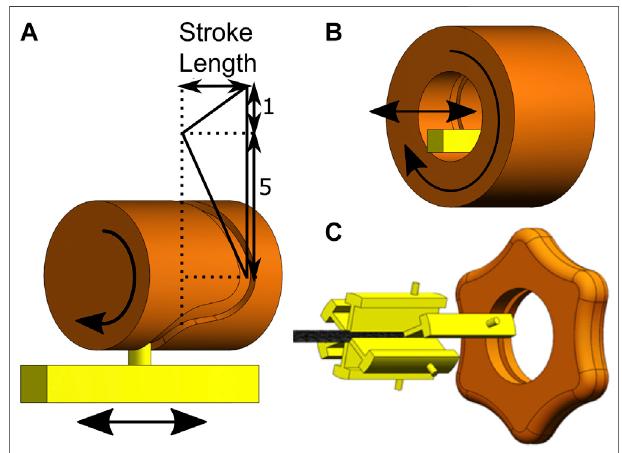
FIGURE 6 | Representation of the cam design. (A) The effect of the groove on the motion sequence of the sliders. (B) Schematic drawing of the inside-out barrel cam. (C) The cam (orange) and sliders (yellow) of the transport mechanism.